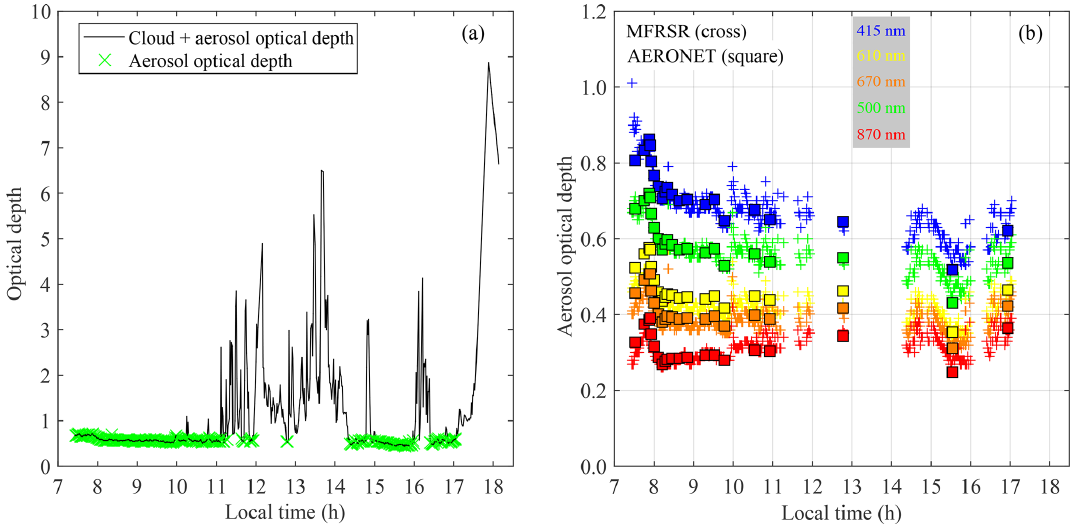
Figure 3. (a) Example of the cloud screening procedure applied to the MFRSR aerosol optical depth retrievals (22 November 2012). (b) Cloud screened diurnal cycle of multichannel aerosol optical depth from MFRSR compared with AOD retrievals from the AERONET Level 2.0